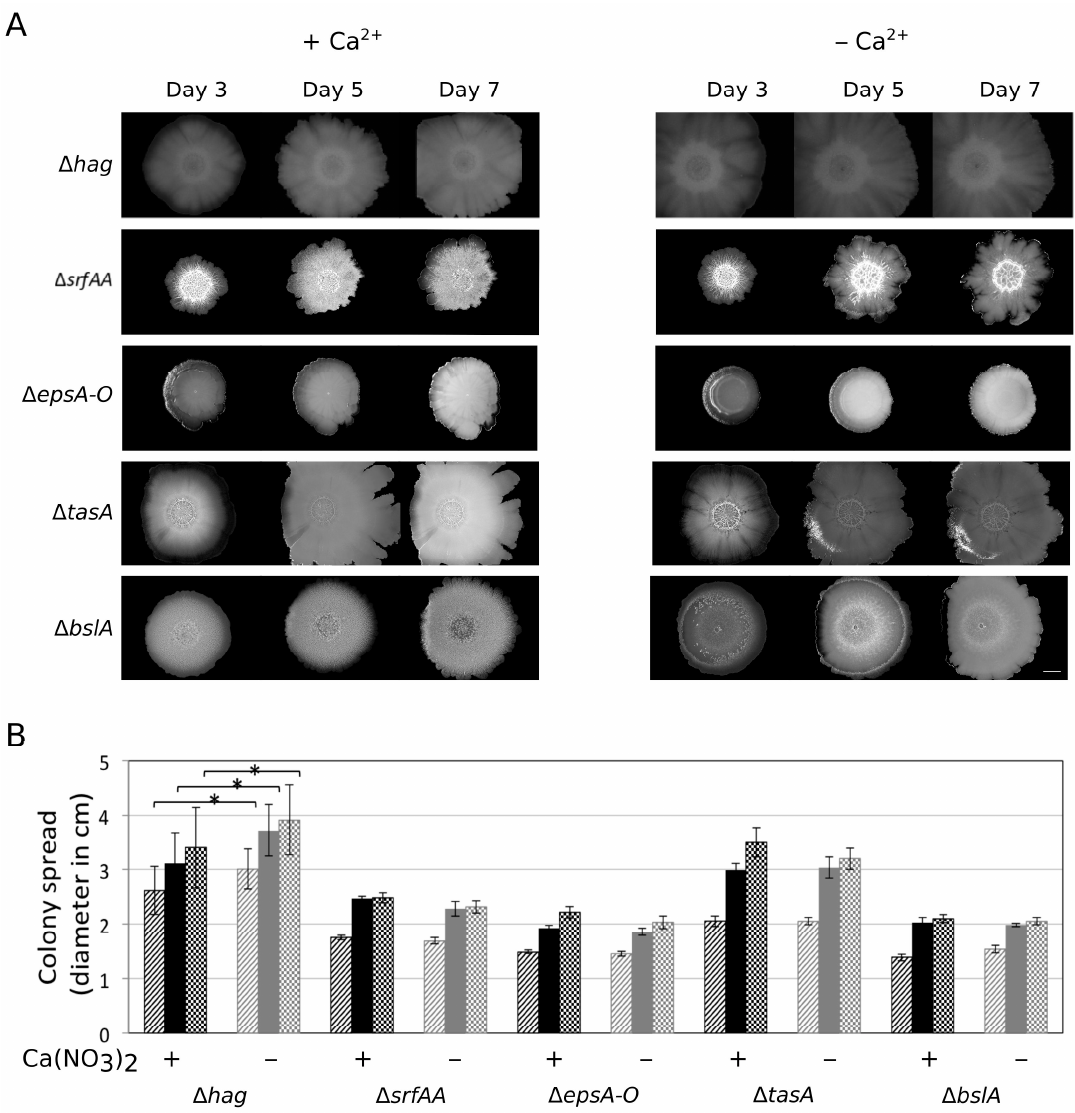
Figure 2. Colony expansion of various mutants of B. subtilis . ( A ) The colony images of ∆ hag , ∆ srfAA , ∆ epsA-O , ∆ bslA , and ∆ tasA strains are shown three, five, and seven days after inoculation on 2 × SG medium in the presence or absence of Ca 2+ . The scale bar indicates 5 mm. ( B ) The colony expansion diameters of the mutants presented in panel A are shown after three (striped), five (filled), and seven (checked) days. Black bars present data in the presence of Ca 2+ , while grey bars indicate the absence of Ca 2 . The error bars indicate 95% confidence intervals. Data was analysed with paired t-test for significantly different samples (* = p < 0.05).